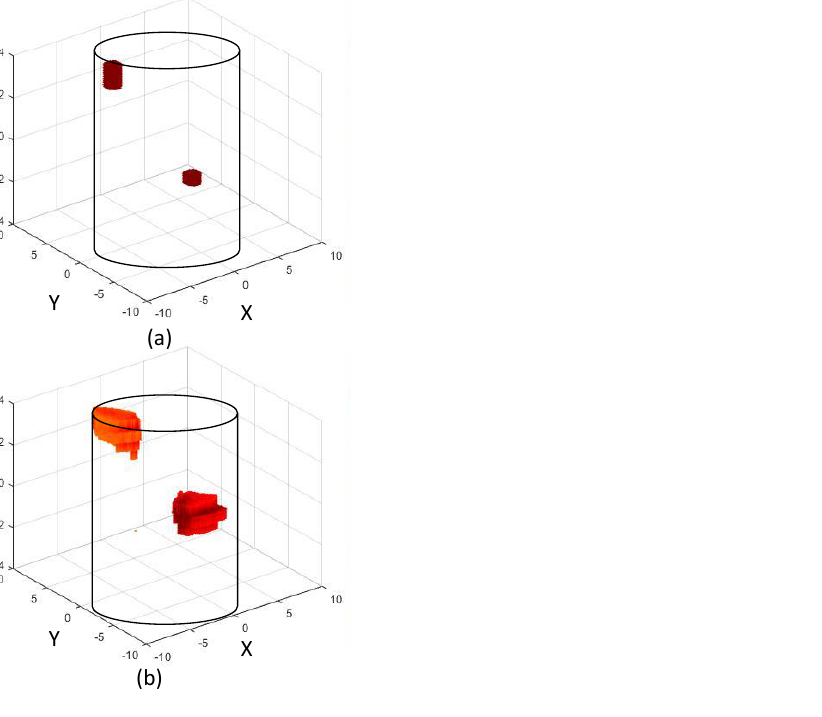
Figure 6. ( a ) Actual anomalies shown inside the 3D cylindrical imaging domain, ( b ) Reconstructed anomalies shown inside the 3D cylindrical imaging domain.